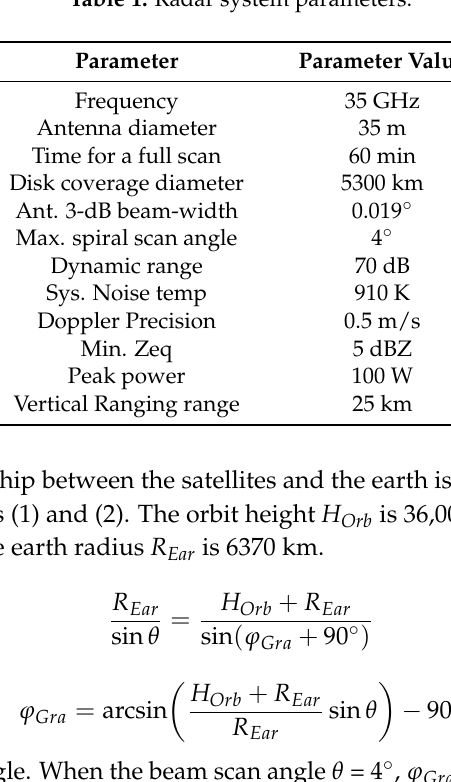
Figure 1. The geometric relationship between Geostationary Spaceborne Doppler Weather Radar (GSDWR) and the earth. The altitude of the geostationary orbit H Orb is 36,000 km and the scan angle θ is from 0° to 4°. ( a ) Spiral scan model; GSDWR performs the spiral scan from nadir to 4° and its horizontal resolution is from 12 km (nadir) to 14 km (4°); ( b ) Model of relationship between satellite and ground angle, describing the relationship between the scan angle θ , incidence angle α , and the grazing angle φ Gra ; ( c ) Antenna scanning strategy, mainly used to describe the relationship between maximum ambiguous distance and PRF. Table 1. Radar system parameters.